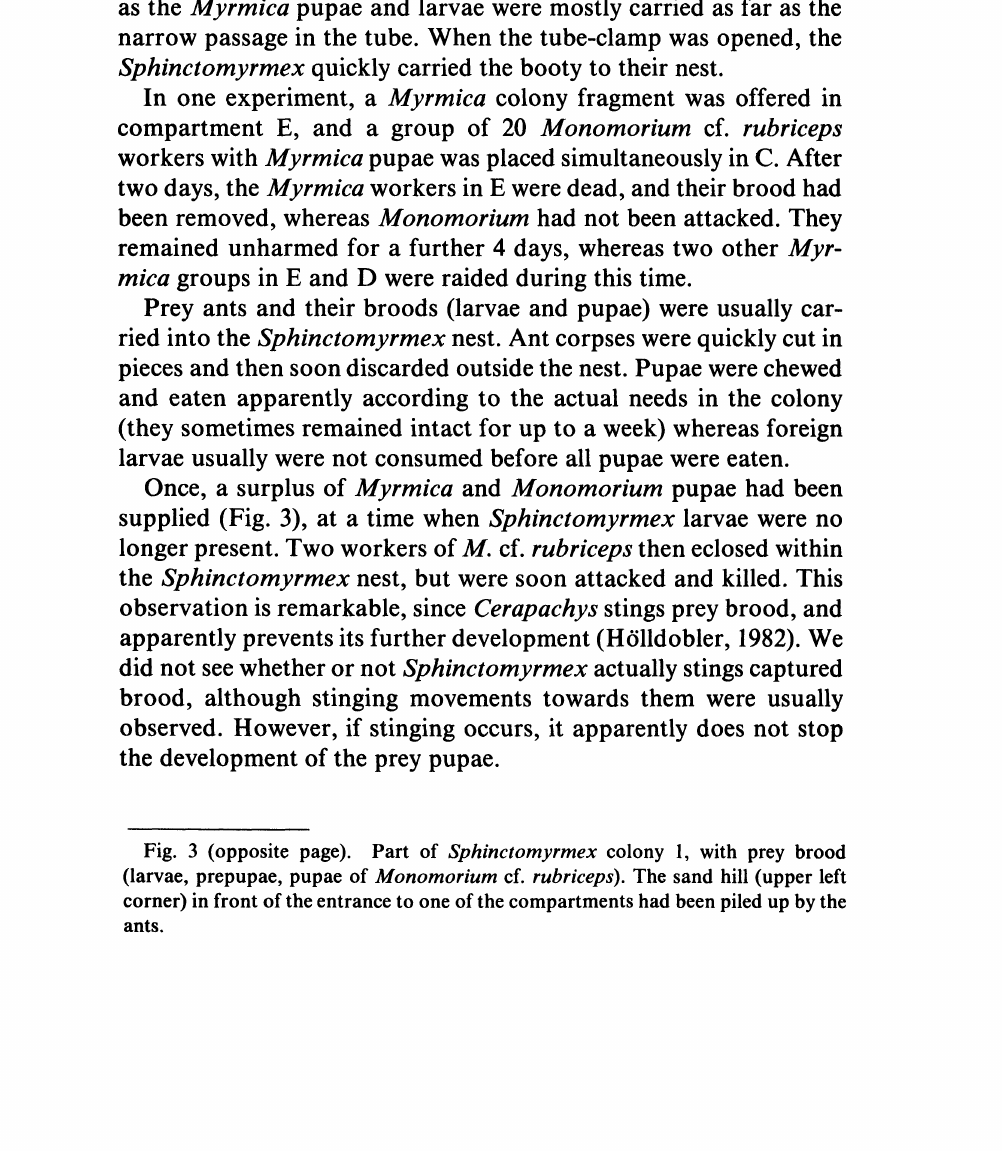
Fig. 3 (opposite page). Part of Sphinctomyrmex colony 1, with prey brood (larvae, prepupae, pupae of Monomorium of. rubriceps). The sand hill (upper left corner) in front of the entrance to one of the compartments had been piled up by the